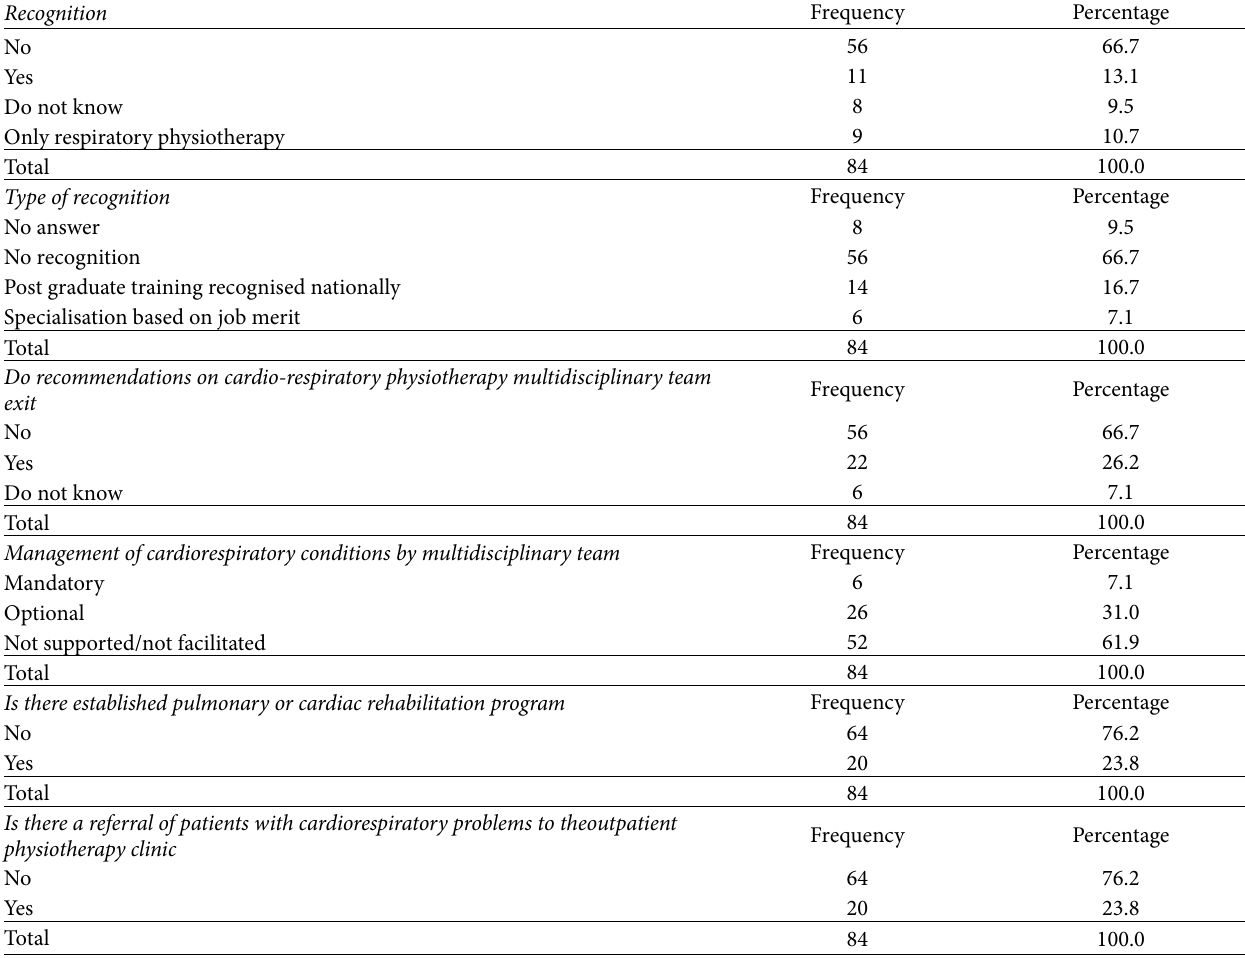
Table 3: Context of cardiorespiratory physiotherapy